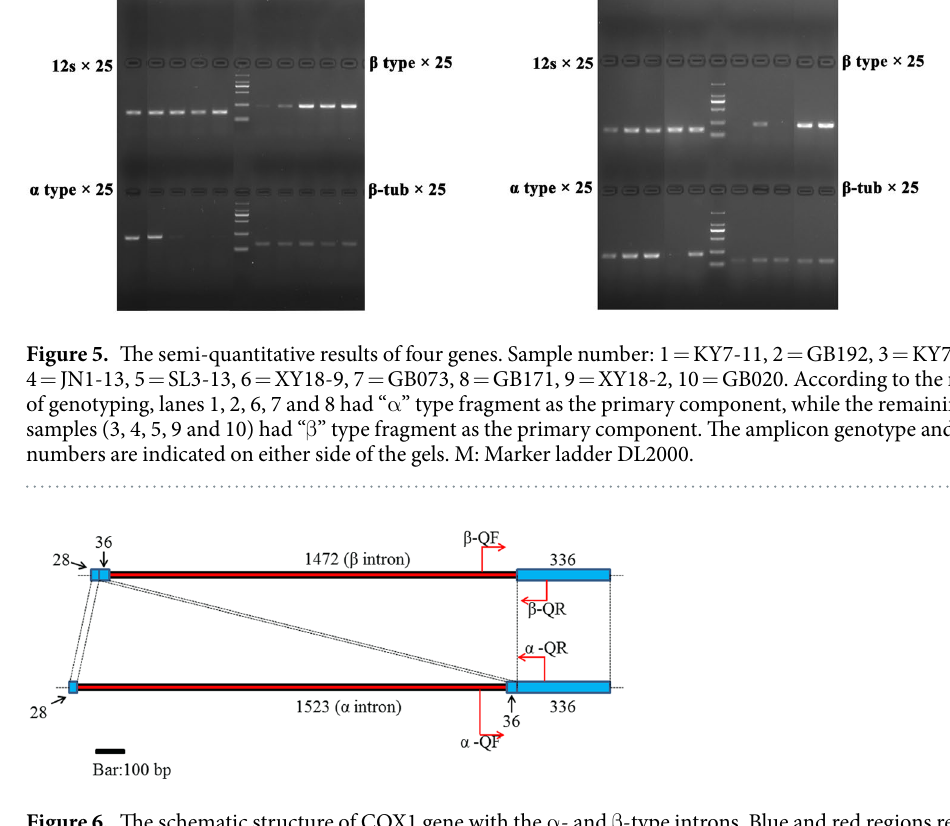
basidiomycete fungi, despite the discovery of linkage equilibrium and phylogenetic incompatibility among alleles at mitochondrial loci in natural populations of several mushroom species 11, 12, 19 . Among other fungal groups, the filamentous ascomycetes Podosphaera leucotricha and Leptographium truncatum have been the only ones reported so far to have heteroplasmic isolates in nature 15, 16 . In P. leucotricha , three heteroplasmic isolates (out of 36 isolates total) were found in apple orchards treated with the strobilurin fungicide. Strobilurin targets the mito- chondrial cytochrome b (cytb) protein. Strobilurin-resistant isolates were found to contain both a wild type copy and a mutated copy of the cytb gene 15 . Interestingly, though the fungicide pressure was necessary to select for the resistant allele and to establish the heteroplasmic state, heteroplasmy at the cytb locus was maintained six years after the initial isolation in the absence of strobilurin. In L. truncatum , two out of 47 isolates were found to be heteroplasmic at the 12S rRNA gene, with some copies of this gene containing a Group II intron while others did not 16 . In contrast, in all other fungi examined so far, heteroplasmic isolates were only found in laboratory crosses. In addition, in all these laboratory cases, heteroplasmy was only a transient state, segregating into homoplasmic progeny very quickly during subsequent cell divisions 3, 5, 8, 20, 21 . At present, the reason(s)/mechanism(s) for the frequent heteroplasmy in Th. ganbajun is not known. One potential contributor was cross contamination among samples and this could occur during fruiting body col- lection, DNA extraction, PCR and/or sequencing. We tested this possibility by analyzing additional tissues from each of the 12 samples with evidence of COX3 heteroplasmy, paying close attention to all stages of our exper- iments. Our analyses identified that all 12 samples had exactly the same sequence type as those of the initial analyses. Together, the three pieces of evidence, (i) the homoplasmic COX3 sequences for the other 272 isolates,